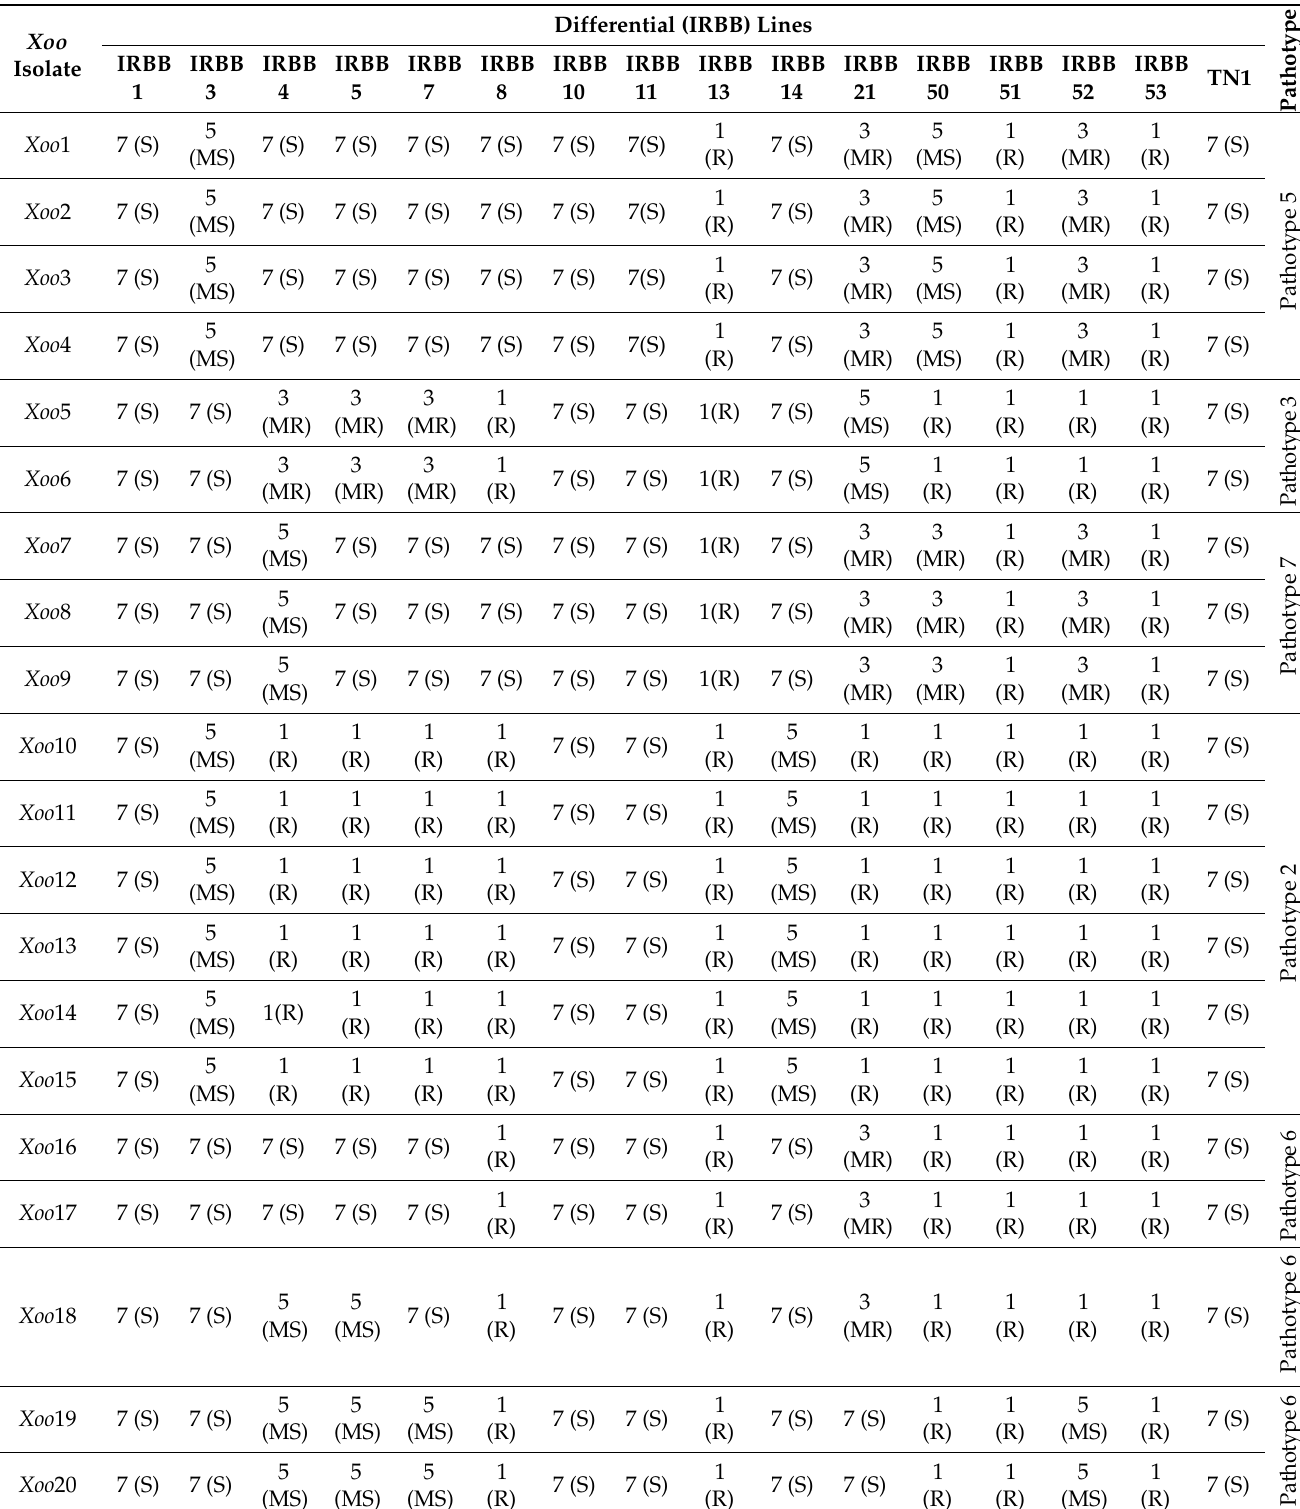
Table 5. Virulence profiling of Xanthomonas oryzae pv. oryzae ( Xoo ) isolates on rice differentials under greenhouse conditions during kharif